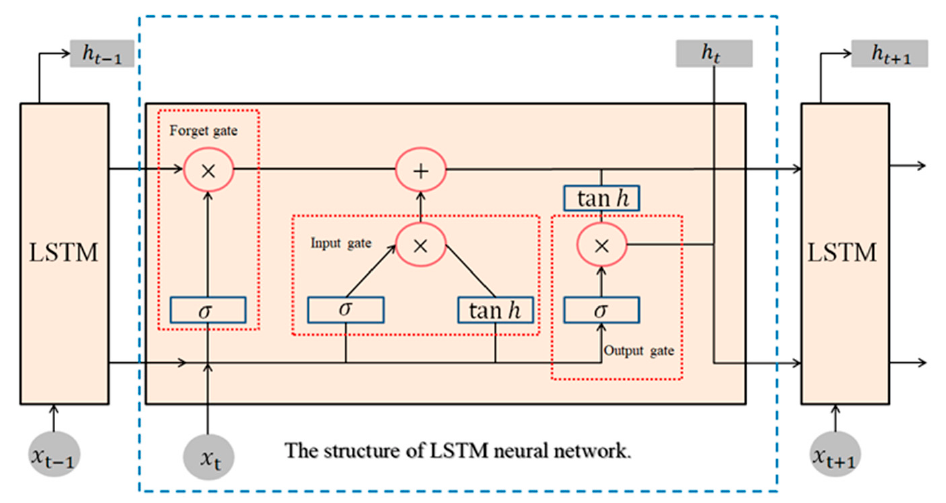
Figure 2. LSTM neural network inner cell structure.